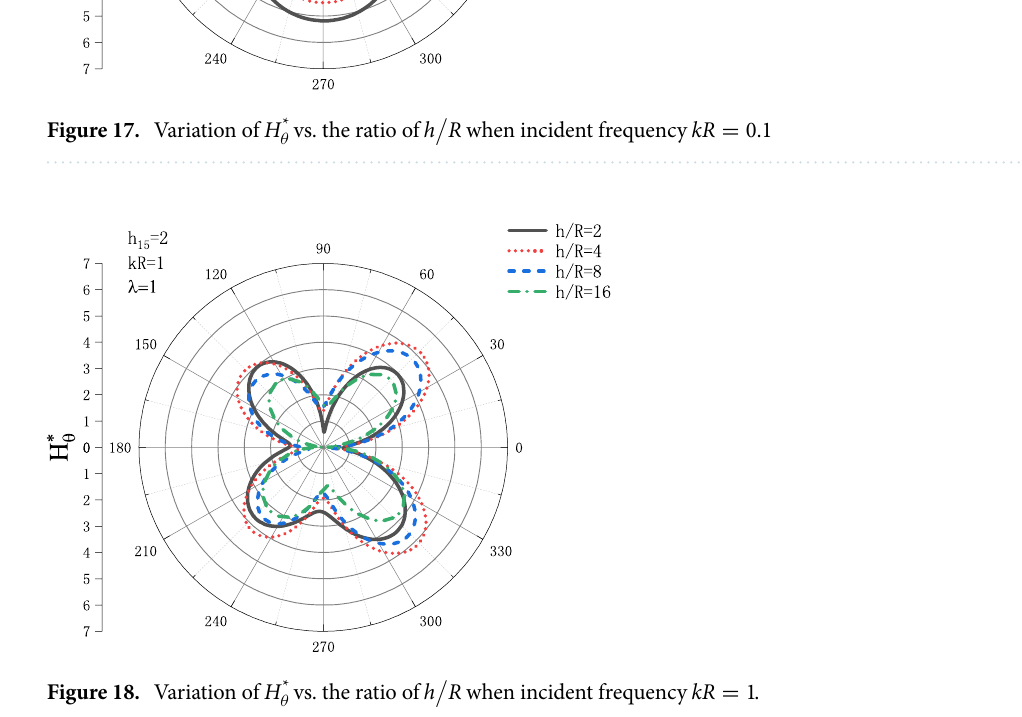
Figure 18. Variation of H